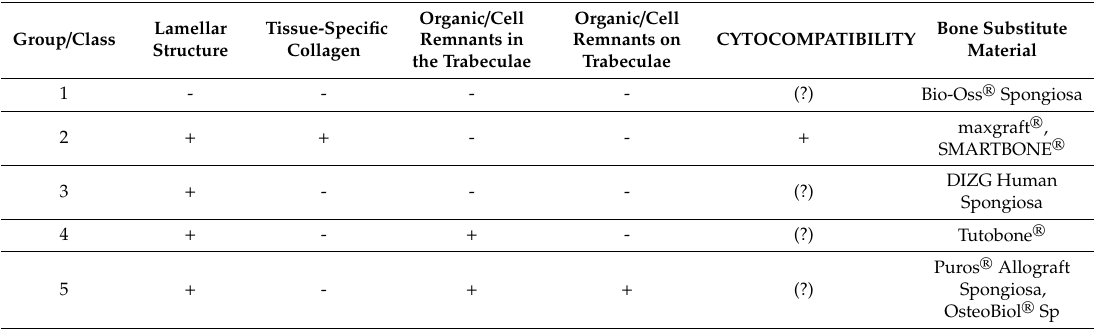
Table 1. Revised classification of available natural blocks for bone regeneration.